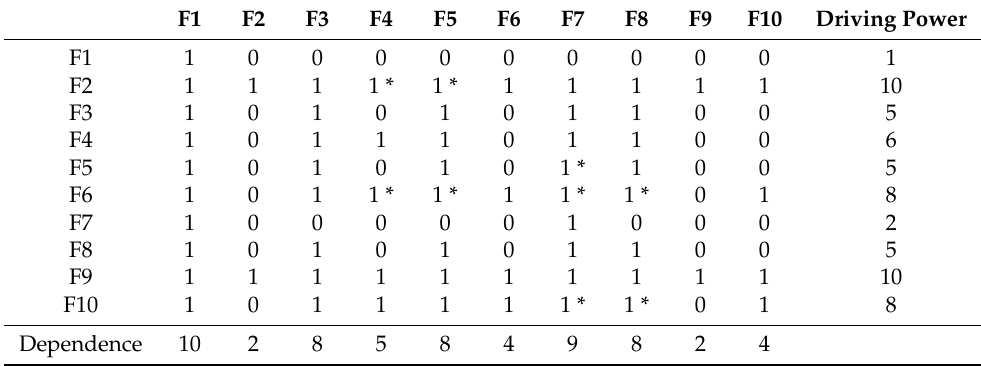
Table 3. Final reachability matrix factors influencing green operations strategies in